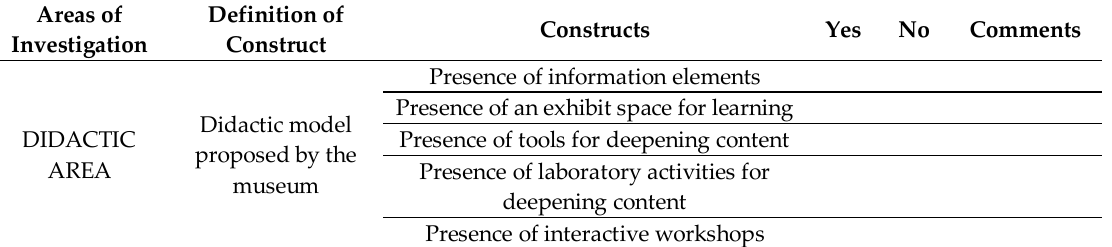
Table 1. Quality Evaluation Form for museum websites, teaching